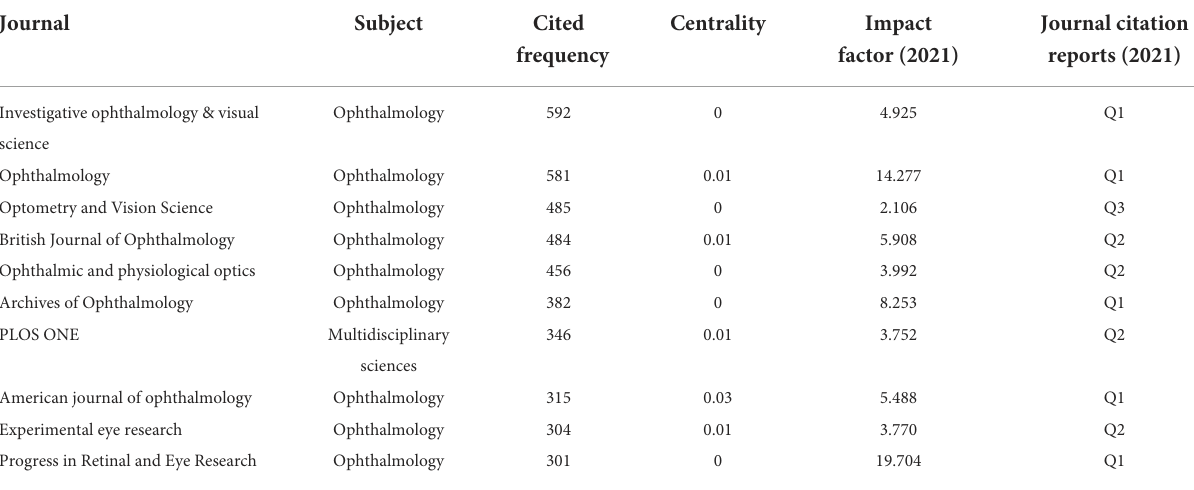
TABLE 3 Top 10 Journals with the most cited from 2006 to